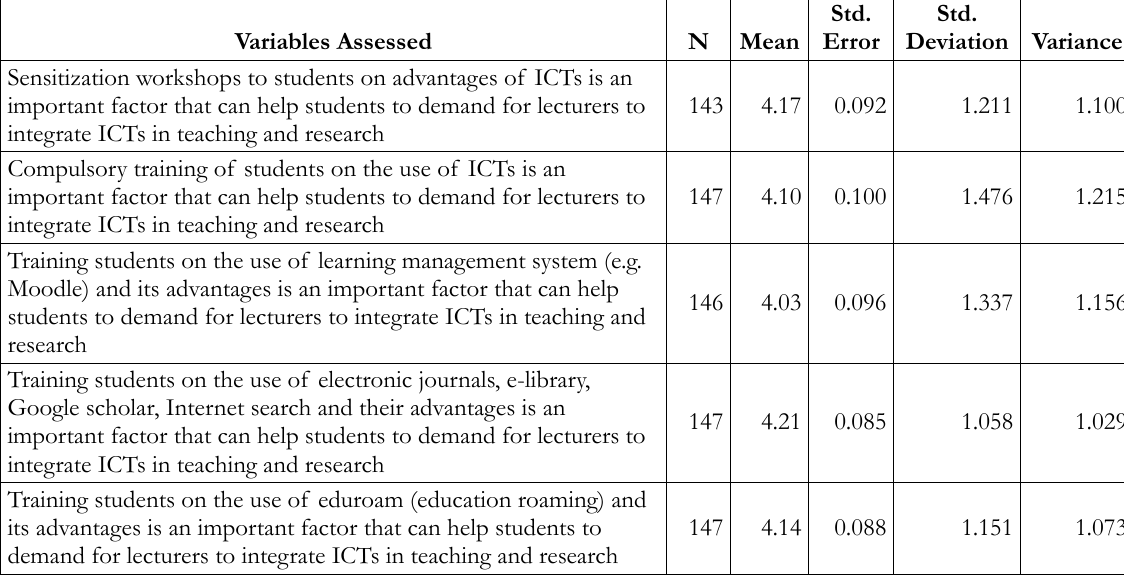
Table 5. Sensitization and training of students in use of ICTs in teaching and research